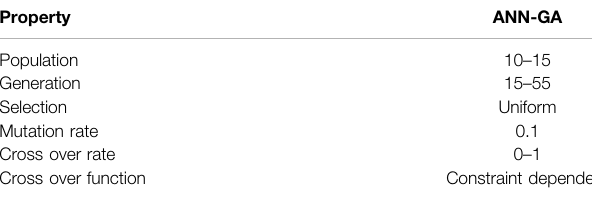
TABLE 3 | Features of the ANN-GA network con fi guration.